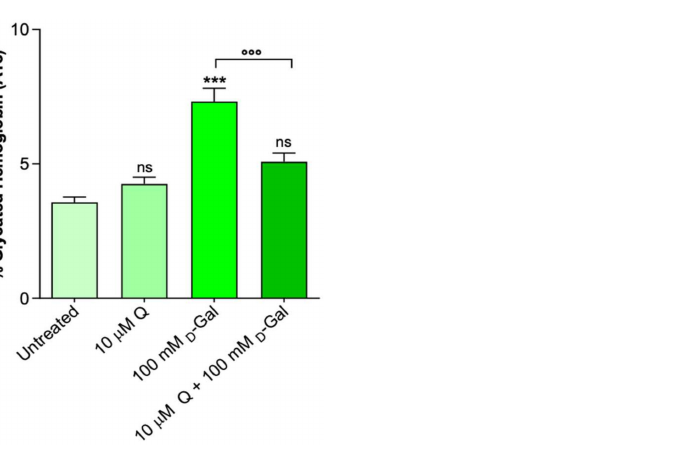
Figure 6. Glycated hemoglobin content (%A1c) in erythrocytes left untreated or incubated for 24 h with 100 mM D -Gal with or without pre-exposure to 10 µ M Q, or 10 µ M Q alone. ns, not statistically significant versus untreated; ***, p < 0.001 versus untreated; ◦◦◦ , p < 0.001 versus 100 mM D -Gal, one-way ANOVA with Bonferroni’s multiple comparison post hoc test ( n = 8).